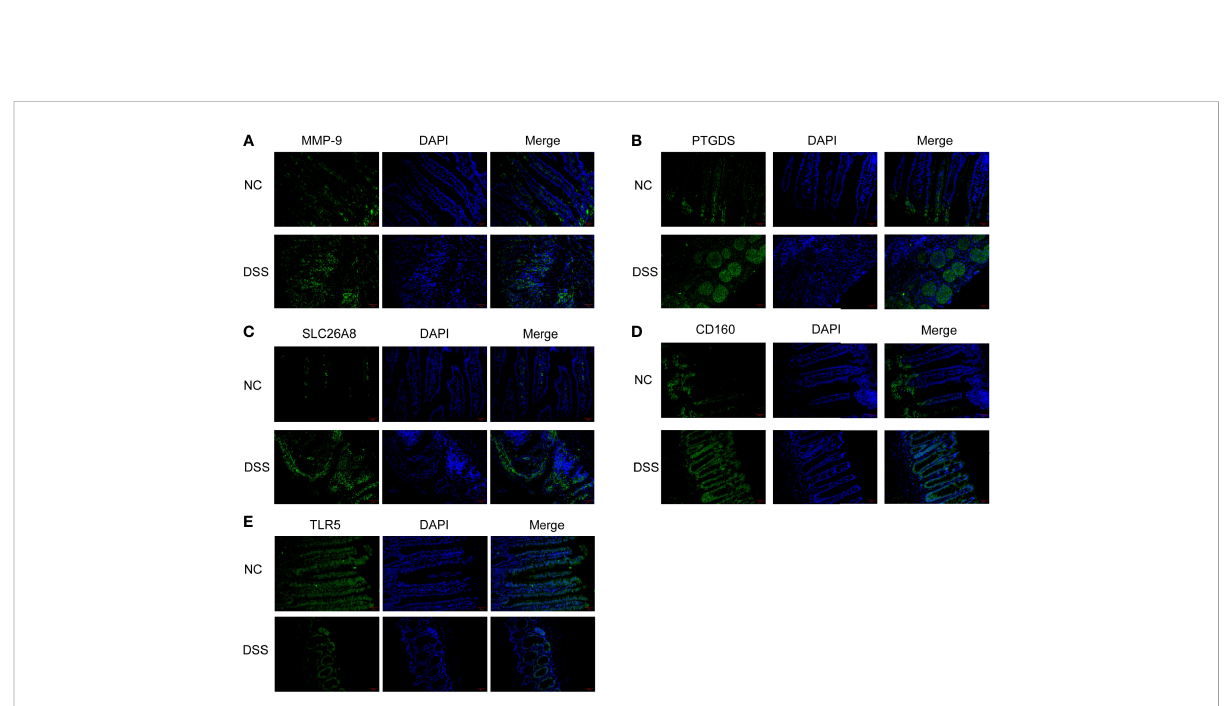
FIGURE 12 Colonic tissue immuno fl uorescence in mice. (A – E) Immuno fl uorescence of CD160, MMP-9, PTGDS, SLC26A8, and